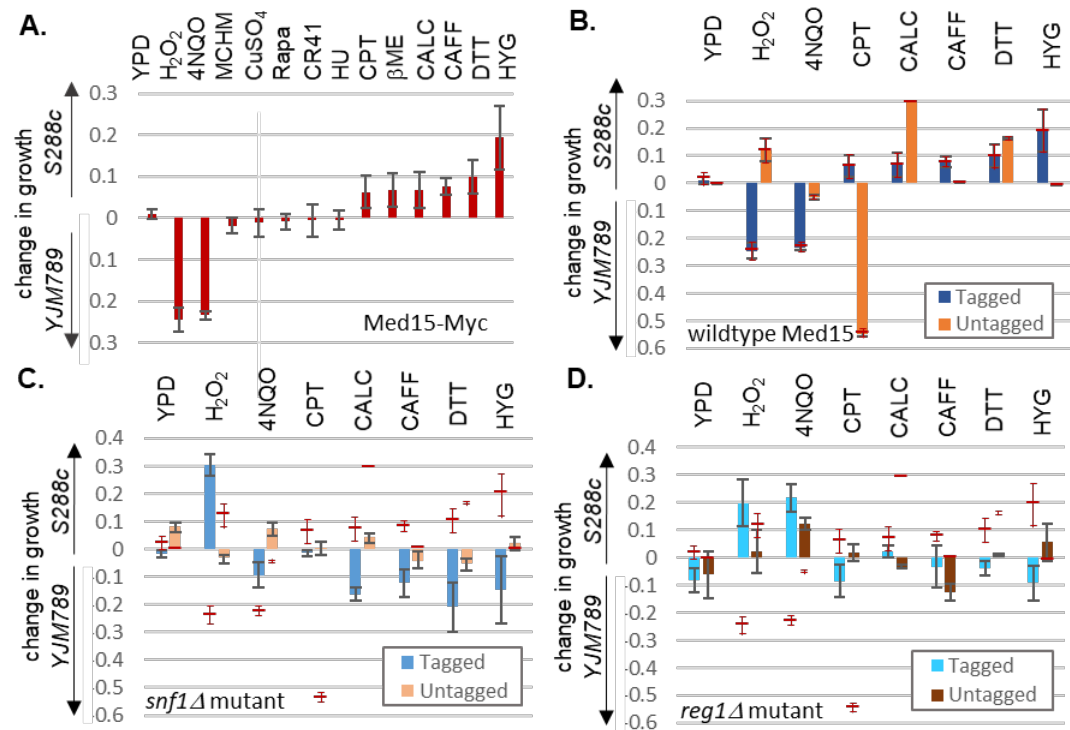
Figure 7. Quantitative growth assays of BY4741 med15 carrying di ff erent alleles of Med15 in snf1 and reg1 mutants with di ff erent drugs. At the time, when there was the maximum growth di ff erence, the OD 600 of yeast carrying Med15 S288c was subtracted from the OD 600 of yeast carrying Med15 YJM789 . Values above the y-axis indicate increased growth of the yeast with Med15 S882c and values below the y-axis indicate that the yeast with Med15 YJM789 grew better than yeast with the other allele. The following chemicals were added: hydrogen peroxide (H 2 O 2 ), 4-nitroquinoline 1-oxide (4NQO), 4-methylcyclohexanol (MCHM), copper sulfate (CuSO 4 ), rapamycin (Rapa), glyphosate (CR41), hydroxyurea (HU), beta-mercaptoethanol ( β ME), calcofluor white (CALC), ca ff eine (CAFF), dithiothreitol (DTT), and hygromycin (HYG). ( A ) Growth of BY4741 med15 yeast carrying di ff erent alleles of Med15-Myc. ( B ) Growth of BY4741 med15 yeast carrying di ff erent alleles of Med15 (untagged, blue) or Med15-Myc (tagged, orange). ( C ) Growth of BY4741 med15 and snf1 yeast carrying di ff erent alleles of Med15 (untagged, light blue) or Med15-13xMyc (tagged, light orange). The respective values of wildtype yeast from panel (B) are shown as a thin red line with the standard deviation range shown as thin red lines. ( D ) Growth of BY4741 med15 and reg1 yeast carrying di ff erent alleles of Med15 (untagged, cyan) or Med15-Myc (tagged, brown). The respective values of wildtype yeast from panel (B) are shown as a thin red line with the standard deviation range shown as thin red